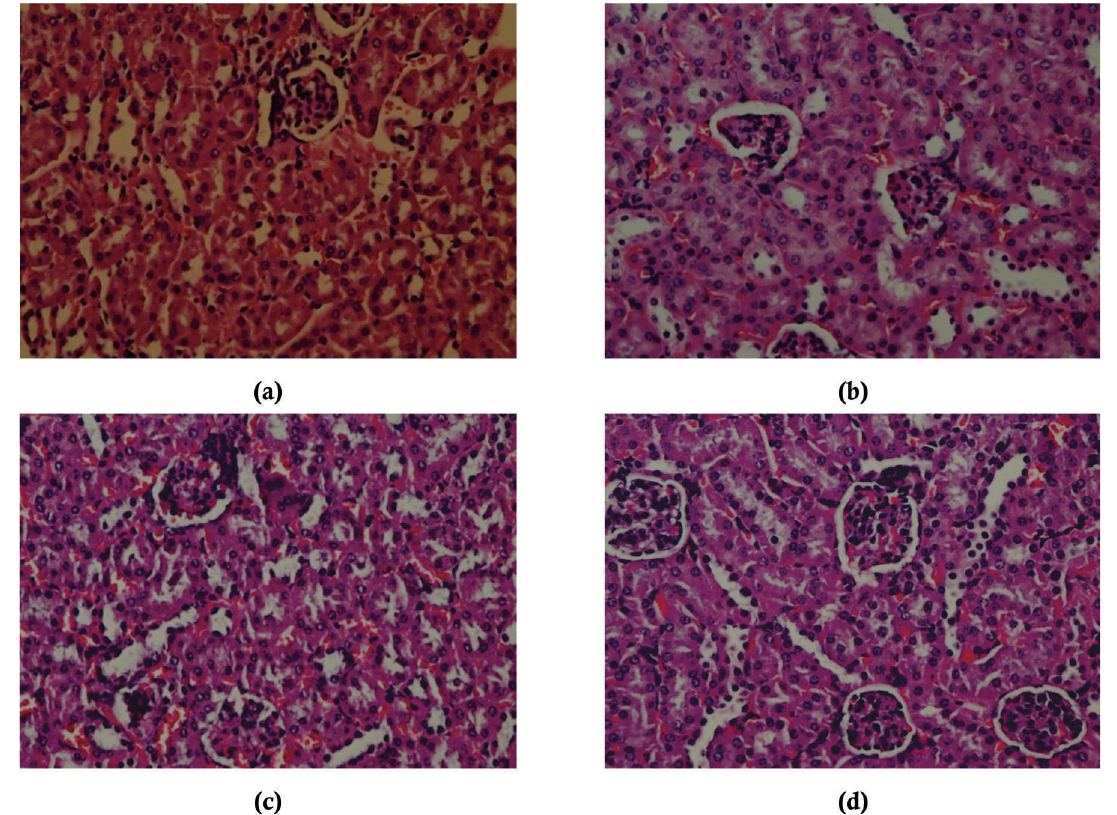
Figure 1. Kidneys’s microscopic view of each group (a) Group C (Control), (b) Group T1 (dose 2000 mg/KgBW), (c) Group T2 (dose 1000 mg/kgBW), (d) Group T3 (dose 500